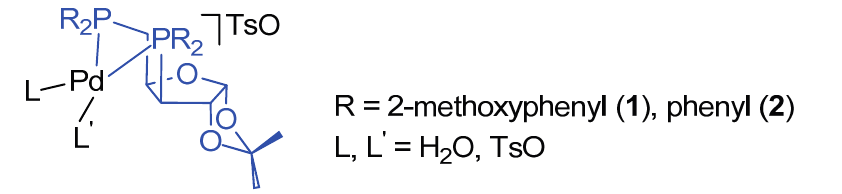
Figure 3. Palladium complexes with o -MeO-xylophos and